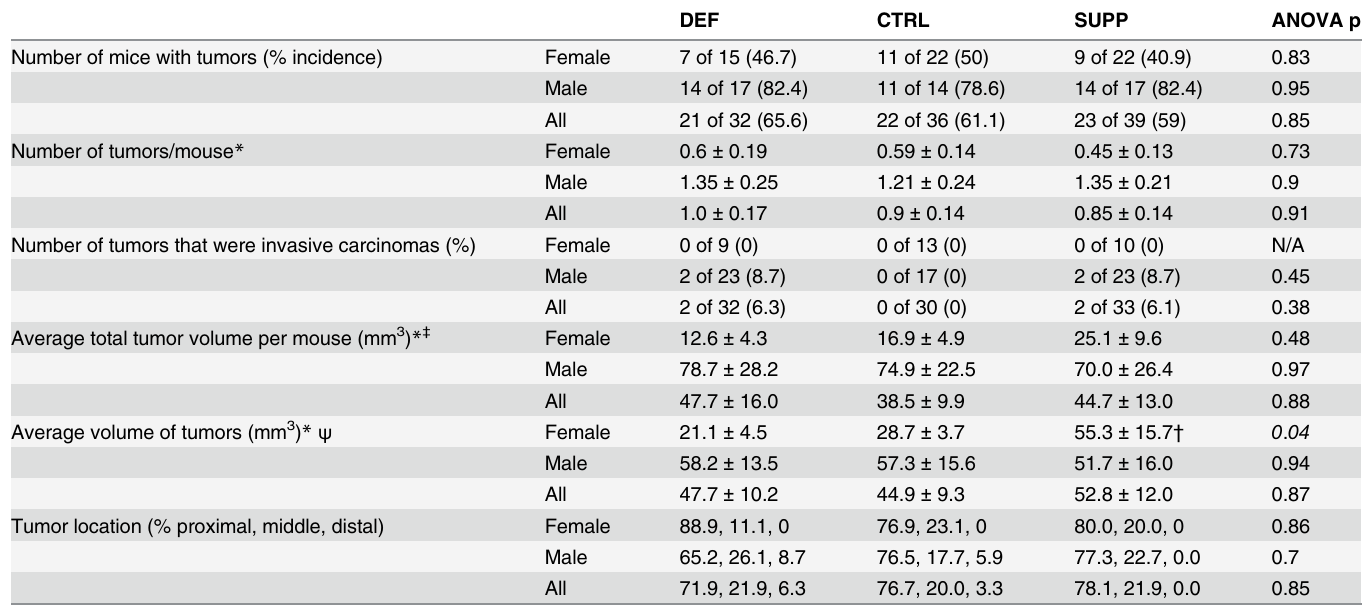
Table 4. Small intestinal tumor outcomes in Apc 1638N offspring of fathers consuming different quantities of B vitamins.